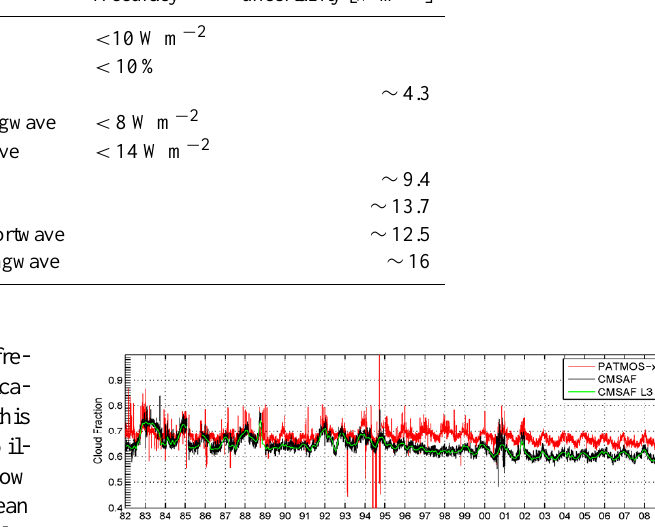
Fig. 13. Daily mean cloud fraction for PATMOS-x (red) and Figure 13. Daily mean cloud fraction for PATMOS-x (red) and CLARA-A1 (black). The green 5 CLARA-A1 (black). The green line shows the corresponding line shows the corresponding monthly mean value for CLARA-A1. Results are computed from 6 monthly mean value for CLARA-A1. Results are computed from Level-2B datasets of all (ascending/descending) overpasses from all Level2B data sets of all (ascending/descending) overpasses from all NOAA satellites. 7 NOAA